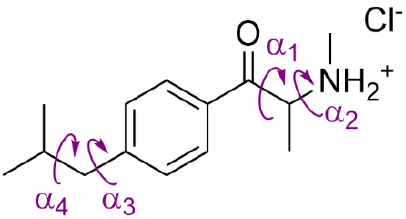
Figure 9. Dihedral angles α 1 , α 2 , α 3 and α 4 of 4-isobutylmethcathinone.